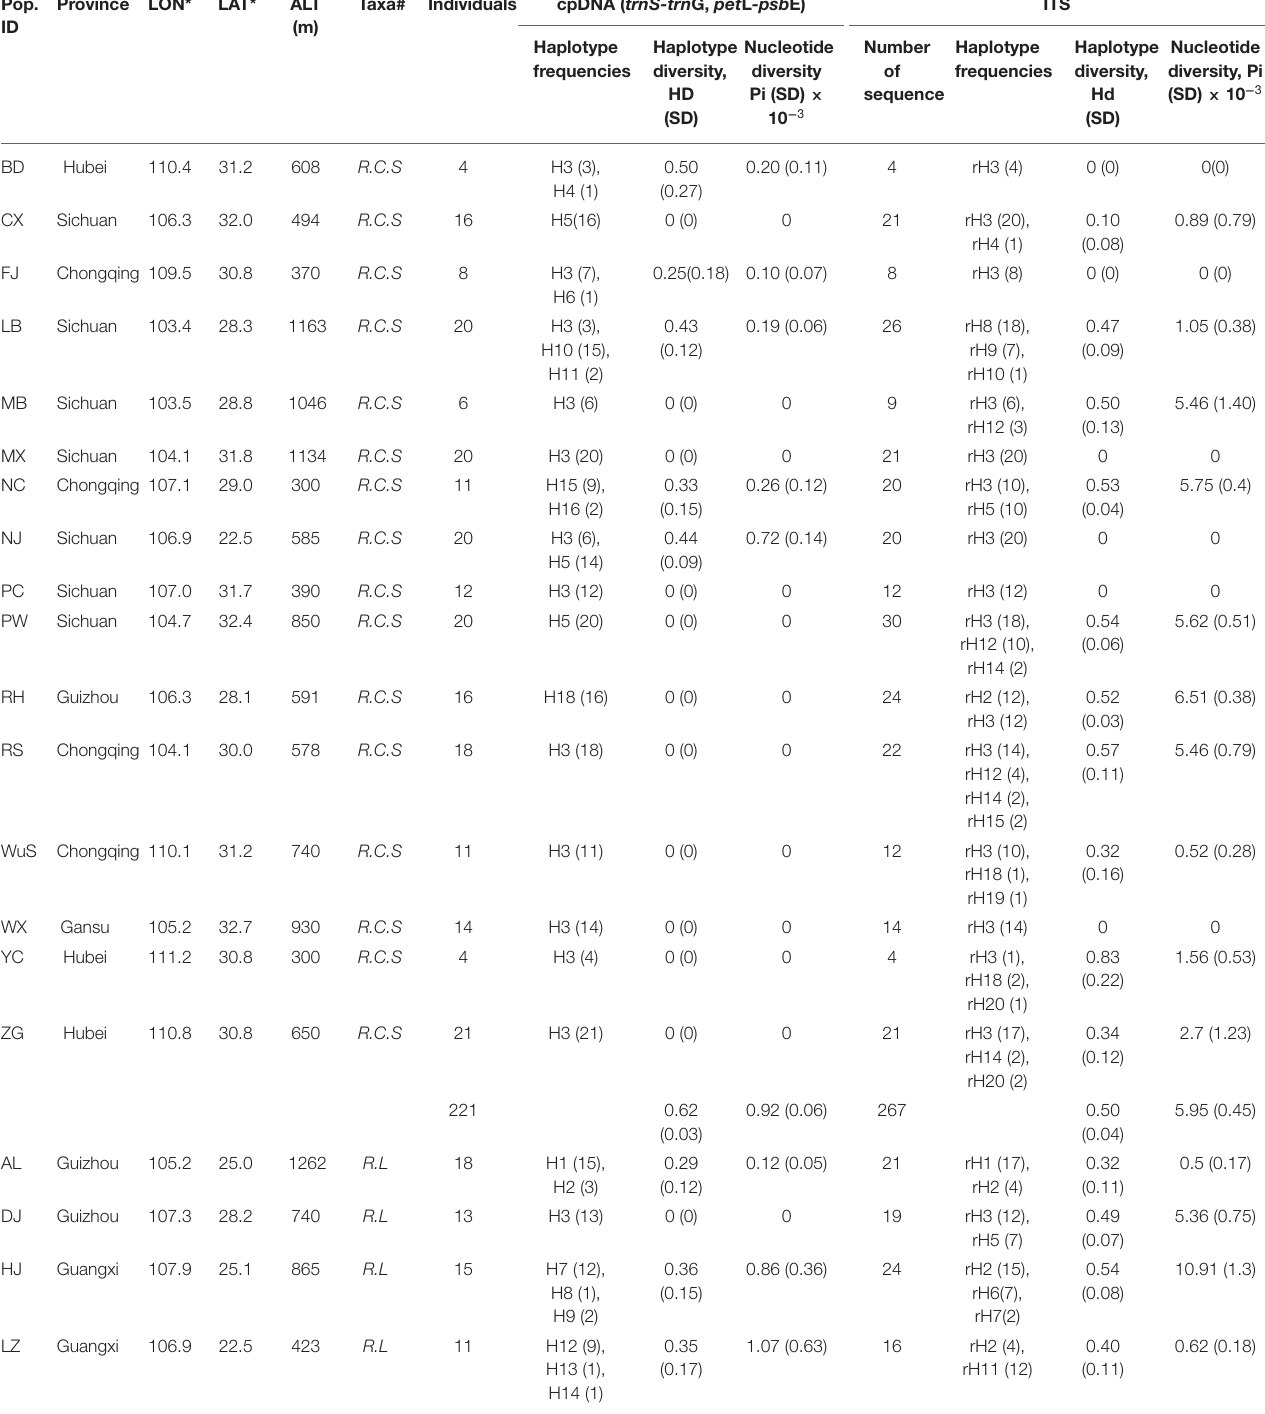
TABLE 1 | Details of the sample locations, sample sizes, haplotype frequencies, haplotype and nucleotide diversity based on cpDNA fragments and ITS. Pop.